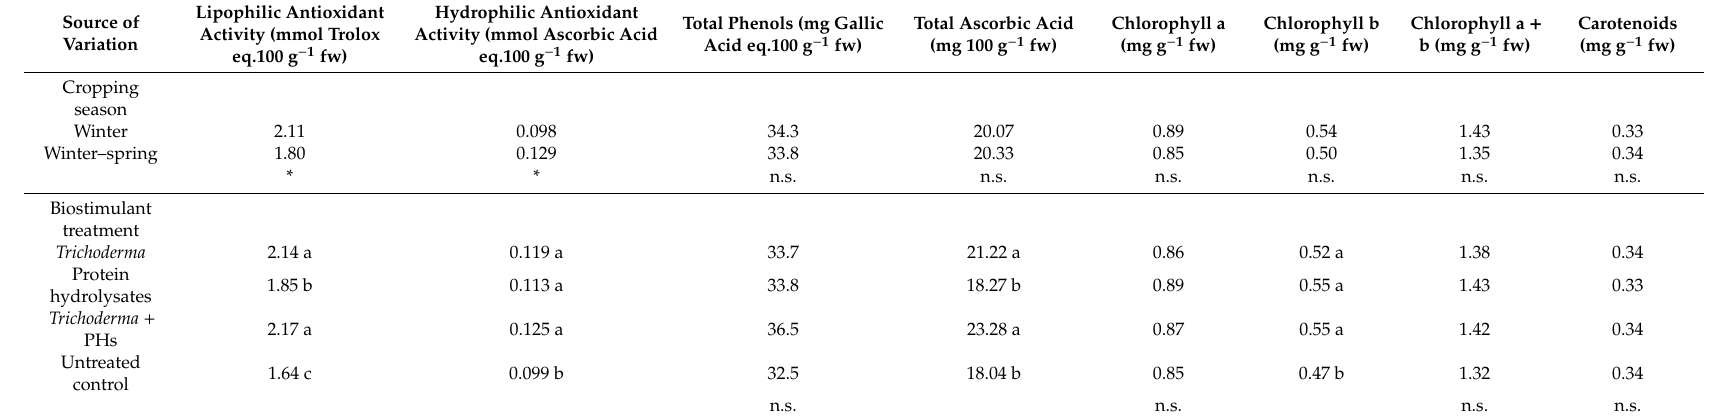
Table 5. Cropping season and biostimulant treatment influence on perennial wall rocket antioxidant compounds and activity. Source of